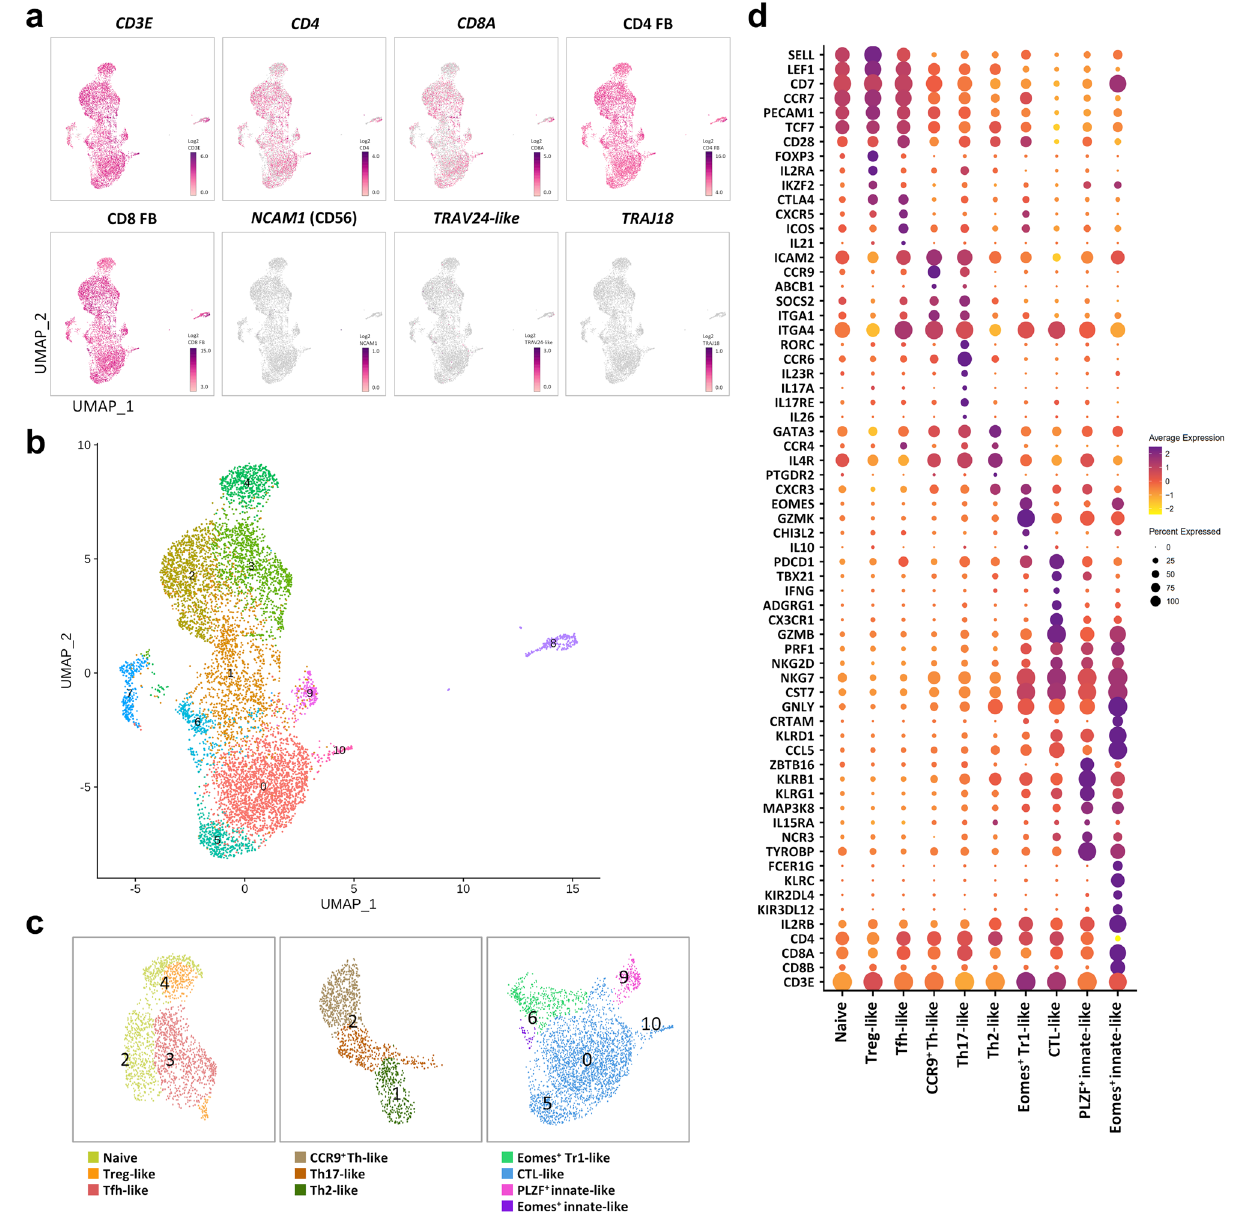
Figure 1. Single-cell RNA-seq analysis of CD4 + CD8 + DP T cells from rhesus monkey. ( a ) UMAP of CD3E , CD4 , CD8A , CD4 FB, CD8 FB, NCAM1 (CD56), TRAV24 -like (TCRVα24), and TRAJ18 (TCRJα18) expression by CD4 + CD8 + DP T cells. ( b ) UMAP representing the clusters of DP T cells from the rhesus monkey. The nearest neighbor algorithm on the Seurat analysis platform revealed 11 distinct clusters (numbered). After filtering, ( c ) ten cell types were defined according to expression of marker genes. The number in UMAP indicates the cluster number. Each color represents a defined DP T cell subset. ( d ) Dot plot showing expression of marker genes in DP T cell subsets. Color represents the average expression of the marker genes, and the dot size indicates the percentage of cells expressing the marker genes in the